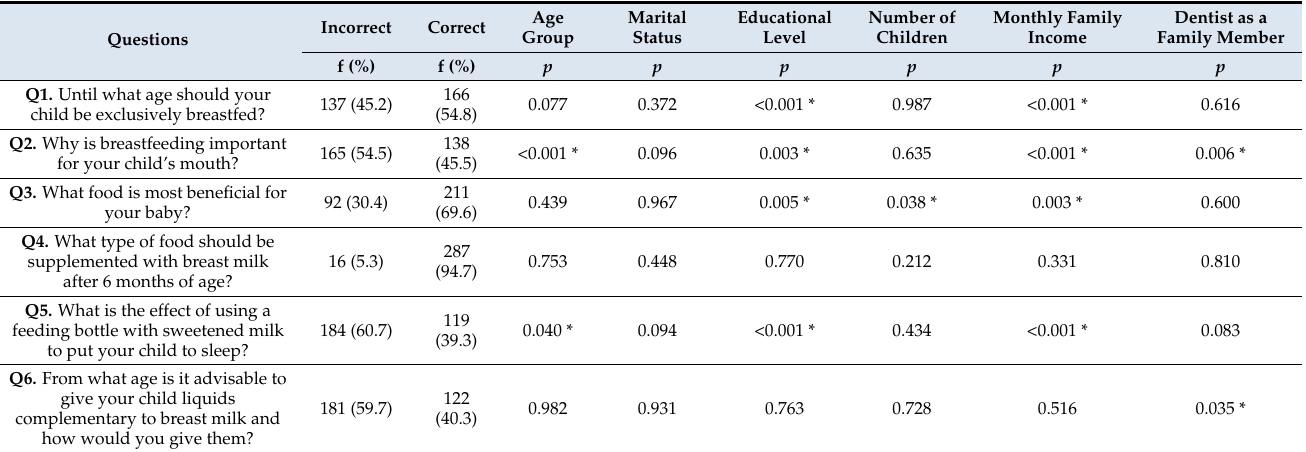
Table 2. Knowledge of early postpartum women about feeding habits in infants aged 0 to 2 years old of age, associated with sociodemographic factors.